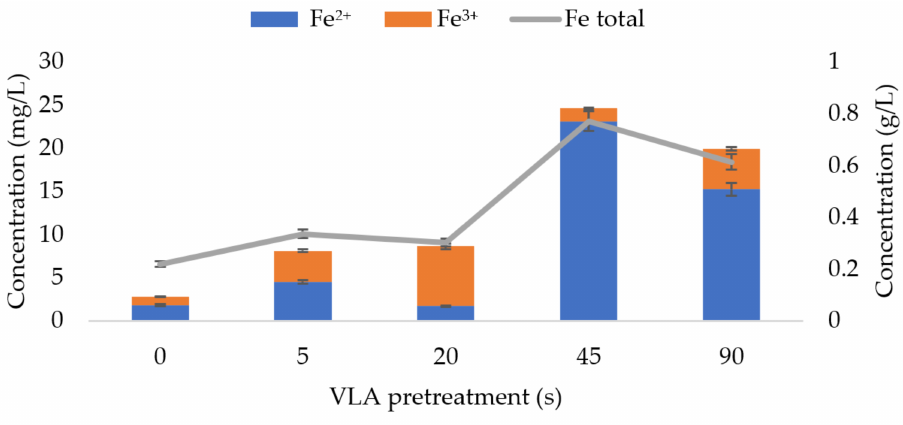
Figure 6. Concentration of total Fe, Fe 2+ , and Fe 3+ after pretreatment in